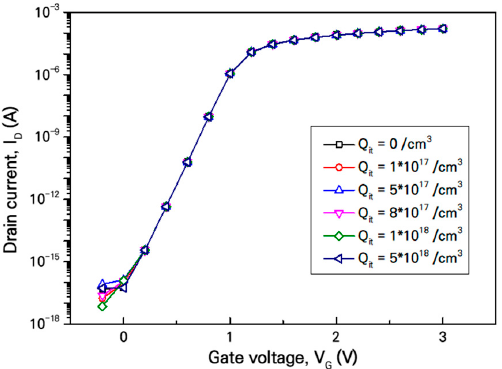
Figure 12. I-V characteristic simulation results obtained using the RH V-gate n-MOSFET radiation damage model with respect to the injected charge concentration.